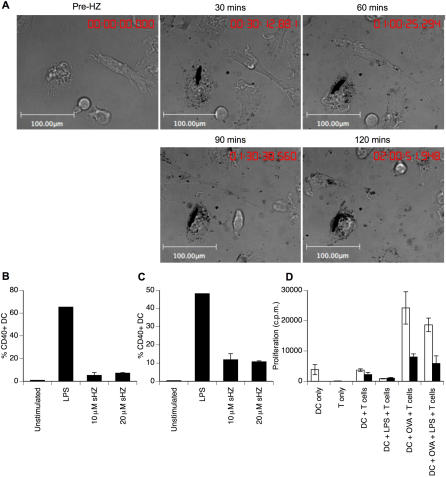
HZ Uptake by DCs Reduces Effector Function(A) BM-derived DCs were visualised by light microscopy prior to and following the addition of 40 μM HZ. Images show the same field of view at 30-min intervals (full video available as Video S1).(B) BM DCs were cultured with the indicated doses of HZ, or with 1 μg/ml LPS. After 24 h, the proportion of CD11c+ DCs expressing CD40 was determined by flow cytometry.(C) After 24 h culture with HZ, 1 μg/ml LPS was added to DCs and the proportion of cells expressing CD40 was analysed 18 h later.(D) DCs were treated with HZ as above (filled bars) or remained untreated (empty bars). DCs were subsequently pulsed with OVA (1 mg/ml) for 6 h prior to stimulation with LPS for 18 h as indicated. DCs were then mixed at a 1:1 ratio with OVA-specific DO11.10 T cells and proliferation assessed by [3H] thymidine incorporation for the last 18 h of a 72 hour culture. Results show the mean of triplicate samples ± 1 s.d.sHZ, synthetic HZ.